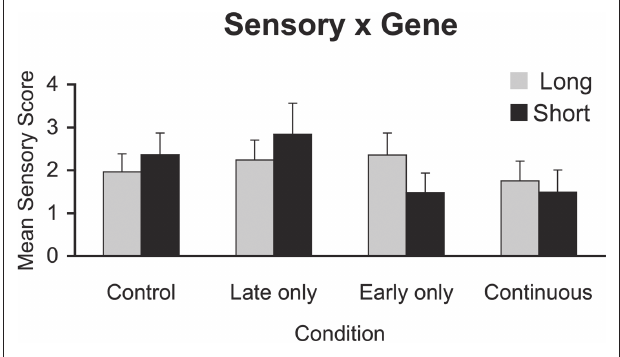
FIGURE 1 | Interactions between timing of prenatal alcohol exposure and rh5-HTTLPR genotype on sensory responsivity behavioral score. A genotype × early alcohol exposure interaction shows behavioral under- responsivity to tactile stimuli in monkeys carrying the short ( s ) rh5-HTTLPR allele compared to middle-to-late exposed and controls regardless of genotype.